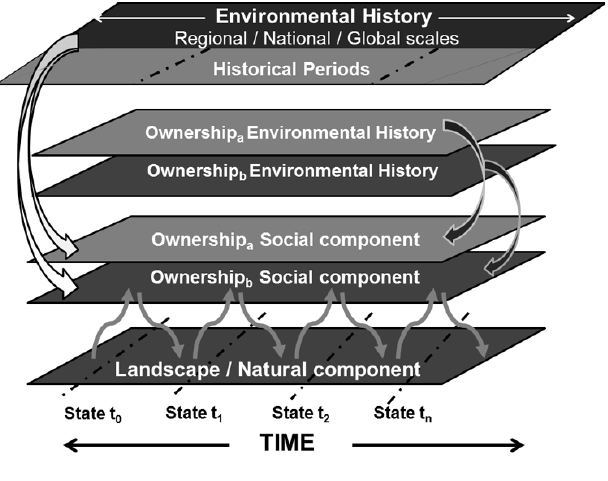
Fig. 1. Environmental history-coupled human and natural systems (CHANS) framework to examine the influence of long- term CHANS feedbacks on current conditions of multiple- ownership forest landscapes. The natural and social landscape components of the system can be examined through time, represented as consecutive landscape states (state t framework comprises four main elements: landscape (level 1), ownership social component (level 2), ownership environmental history periods (level 3), and broad-scale (regional/national/ global) environmental history periods (level 4). Feedbacks,